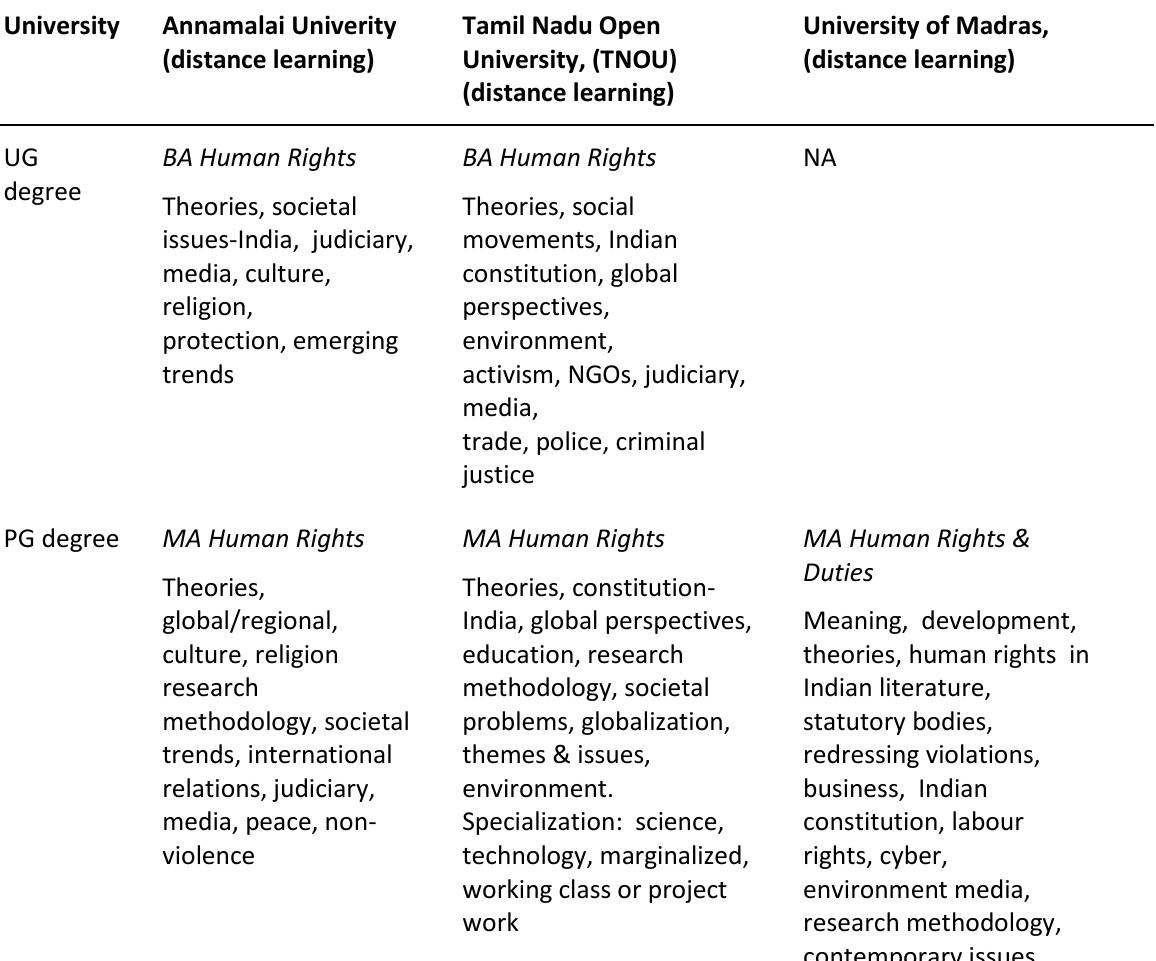
Universities with Human Rights-Specific Programmes in TN in 2020-2021. Adapted from syllabi collected from universities in the case